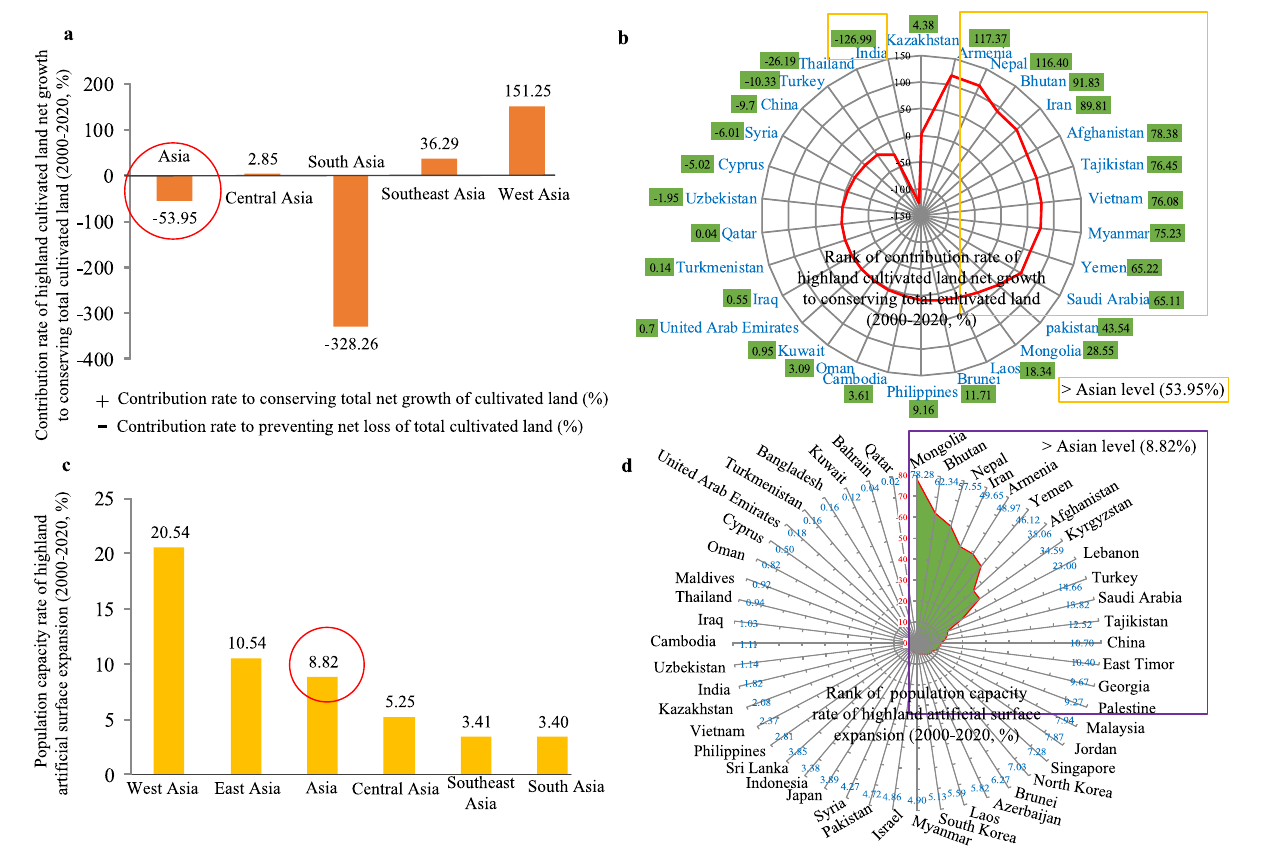
preventing total net loss of cultivated land; positive value (+) denotes the con- tribution rate of cultivated land net growth in highlands for conserving total net growth of cultivated land, see details in Methods part), c population capacity rates of arti fi cial surface expansions in highlands, and d rank of population capacity rates of arti fi cial surface expansions in